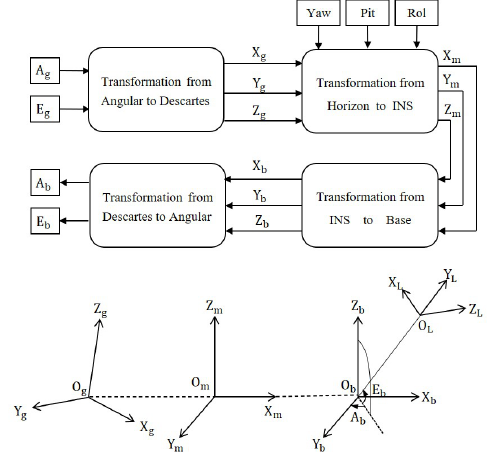
Figure 2. Target pointing process of EOT.